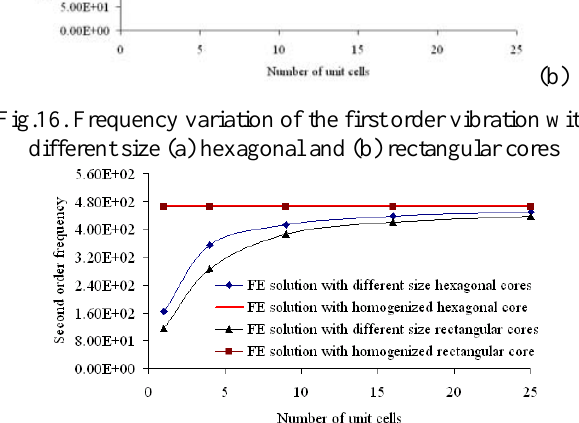
Fig.17. Frequency variation of the second order vibration with different size hexagonal and rectangular cores